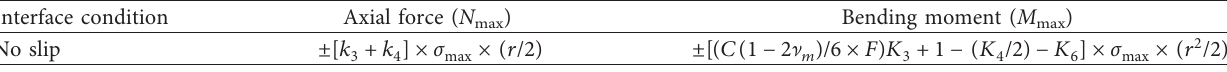
Table 3: Verification.